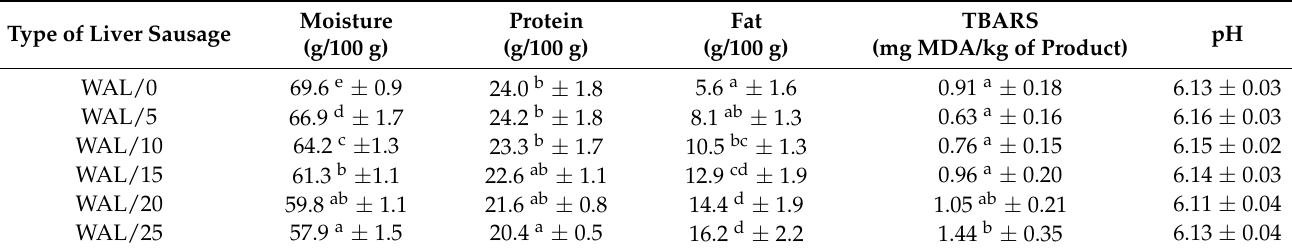
Table 2. Basic chemical composition, TBARS indicator values, and pH level of the liver sausages (mean value ± standard deviation), n =